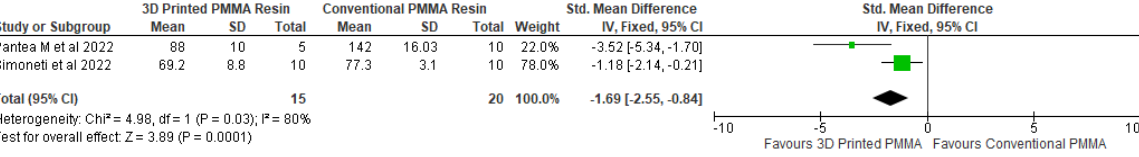
Figure 14. Forest plot comparing flexural strength between 3D-printed PMMA resin and CAD/CAM milled PMMA resin.